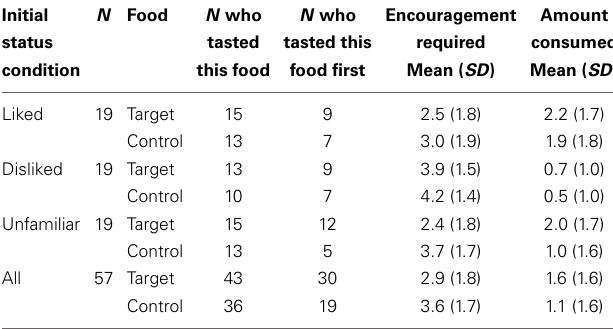
Table 3 | Number of children who tasted the target and control foods, the number who tasted each of these first, and mean ratings of the degree of encouragement required to persuade the child to taste each food (1 = very easy, 5 = very difficult) and amount of each food consumed (0 = none, 4 = whole portion), for each initial status condition and for all groups